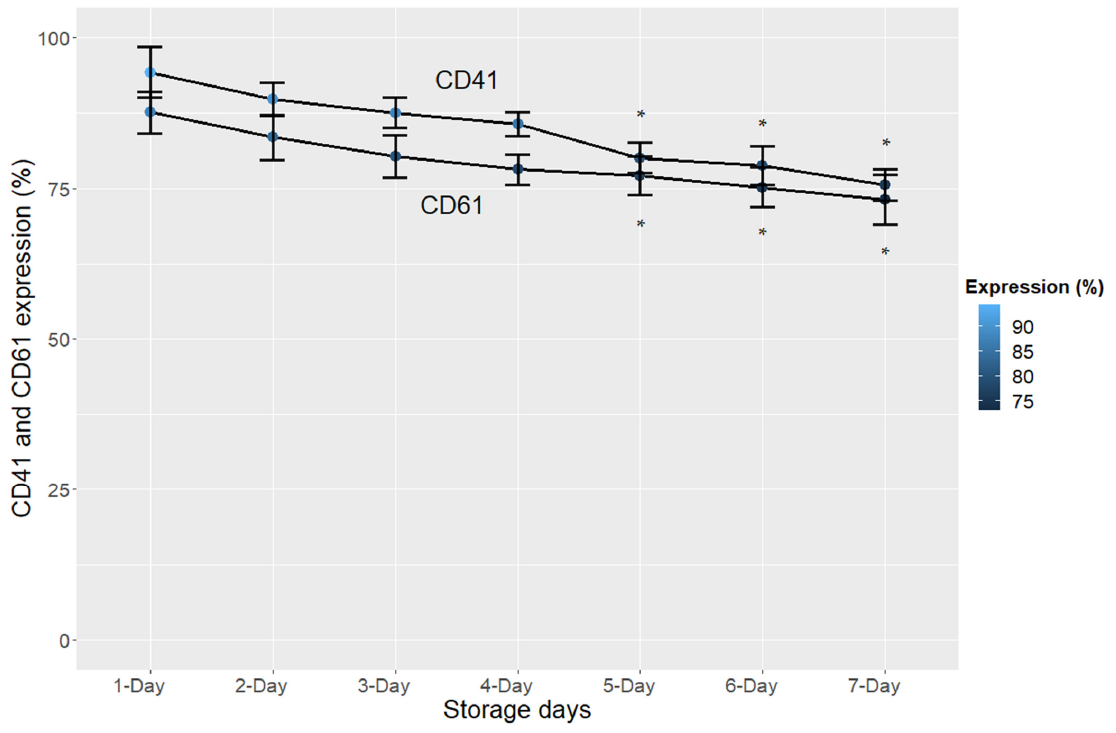
Figure 2. Expression (%) of glycoproteins IIb (CD41) and IIIa (CD61) in platelet concentrates during the 7 days of storage. The error bars represent the variability of the data that were calculated from the standard deviation; * p < 0.05.